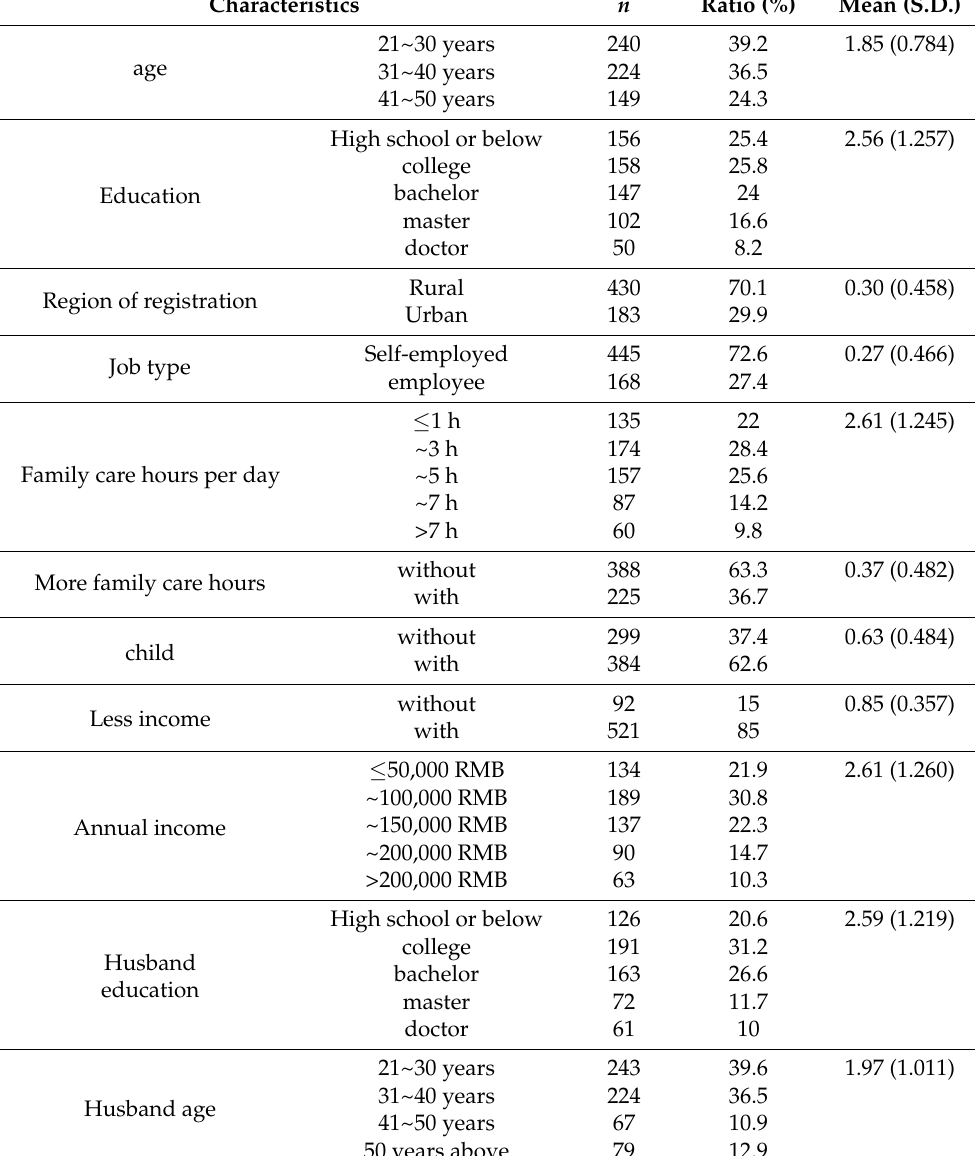
Table 1. Frequency and distribution of the total